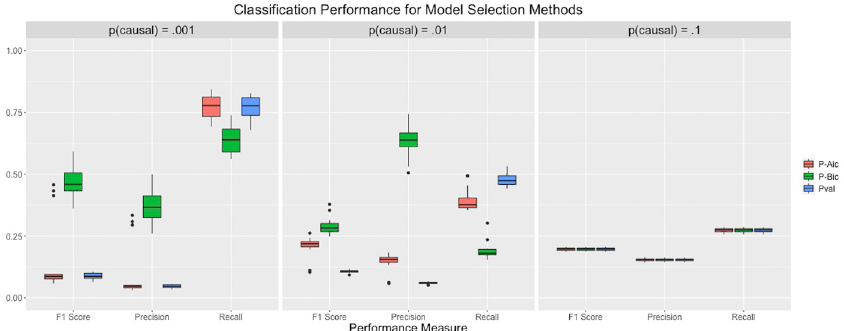
Fig 11. Performance of the selected models for each of the model selection methods across the different simulation settings of simulation 1, as measured by precision, recall, and F1 score. The leftmost box in each grouping of three corresponds to pseudo AIC, the center corresponds to pseudo BIC, and the rightmost corresponds to pseudovalidation. Models were selected from a set of candidate LassoSum models.